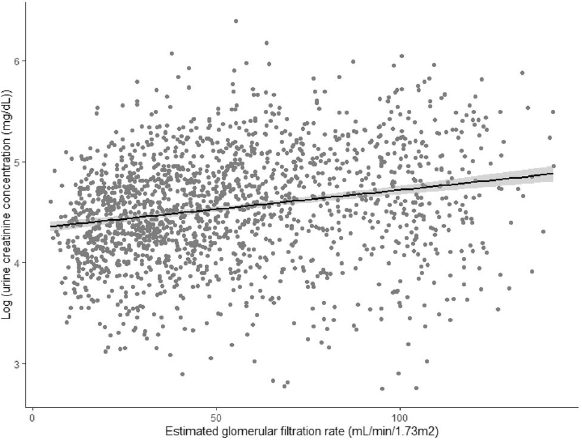
Figure 1. Scatter plot of estimated glomerular filtration rate (eGFR) versus urine creatinine concentration on a log scale. The linear regression is shown as a solid